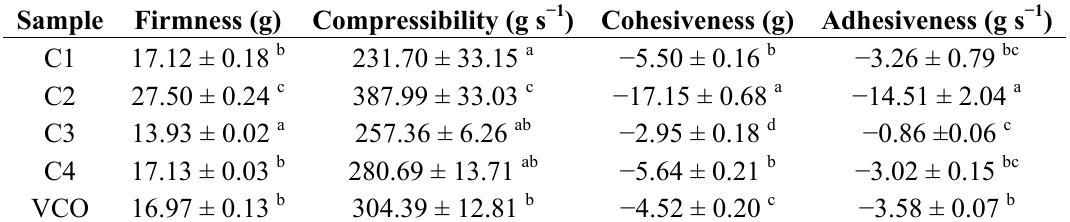
Table 3. Texture properties of the commercial emulsion samples and virgin coconut oil emulsion. Sample